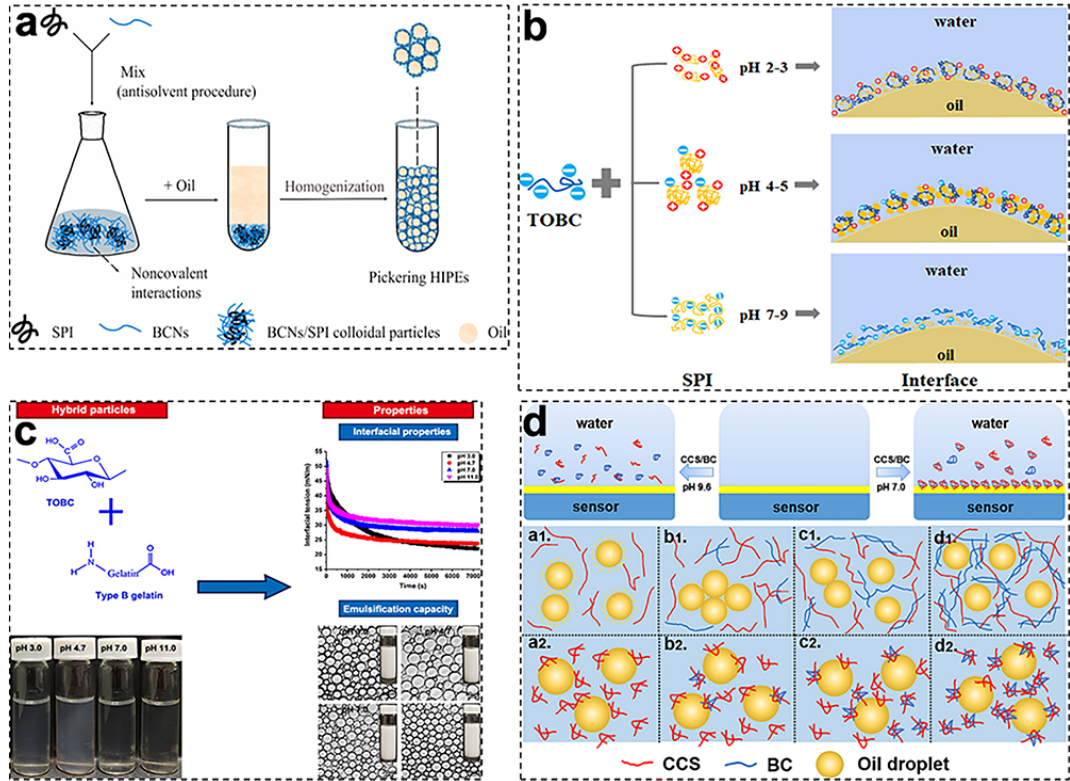
Figure 4. Studies on O/W Pickering emulsions stabilized by BCNF ‐ based complex particles: ( a ) Schematic mechanism for the formation of Pickering high ‐ internal ‐ phase emulsions (HIPEs) stabilized by BCN/SPI composite colloidal particles. Reprinted with permission from [41]. Copyright (2021), Elsevier. ( b ) Schematic illustration of the interfacial adsorption behaviors of SPI/TOBC complexes at different pH values (2–9). Reprinted with permission from [56]. Copyright (2021), Elsevier. ( c ) Appearance and interfacial properties of TOBC–gelatin (GLT) mixtures, and morphology of TOBC/GLT ‐ mixture ‐ stabilized emulsions. Reprinted with permission from [44]. Copyright (2022), Elsevier. ( d ) Schematic illustration of the interfacial adsorption behaviors of BC/carboxymethyl chitosan (CCS) dispersions at the O/W interface investigated by QCM ‐ D, and stabilization mechanism of BC/CCS ‐ based emulsions: a, CCS only; b, CCS with a few BCs; c, CCS with many BCs; and d, CCS with very many BCs. The pH values were controlled between 9.6 ( a1 – d1 ) and 7.0 ( a2 – d2 ). Reprinted with permission from [46]. Copyright (2022), Elsevier.